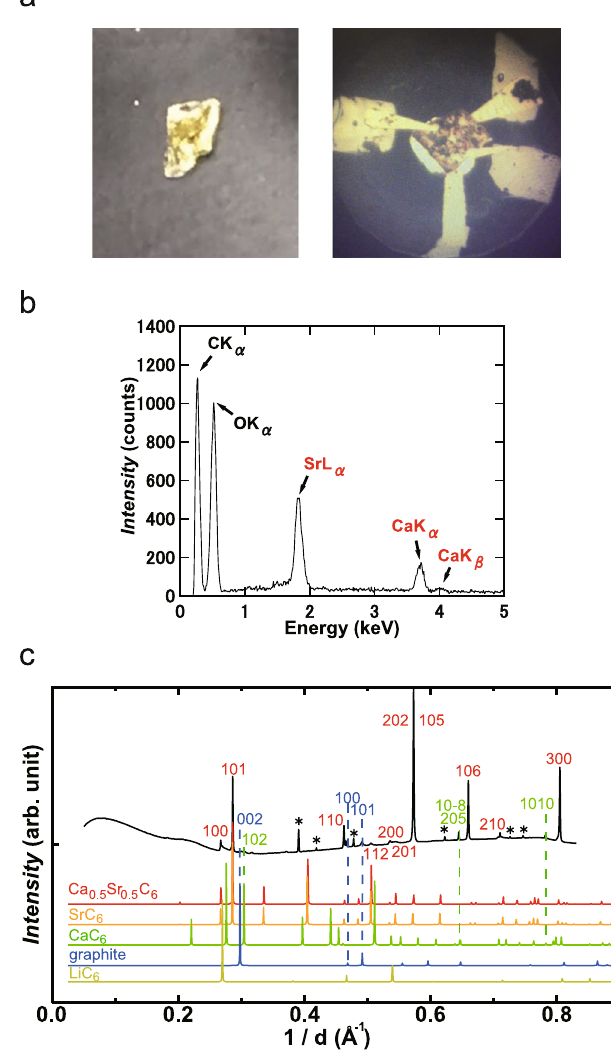
Figure 2. ( a ) Optical image (left) of the Ca 0.8 Sr 0.2 C y sample and microscope image (right) of the sample set in the DAC. ( b ) EDX spectrum of Ca 0.8 Sr 0.2 C y . ( c ) XRD pattern of Ca 0.5(2) Sr 0.5(2) C y . The XRD pattern was measured with synchrotron radiation of λ = 0.68841 Å at room temperature. Patterns shown in ( c ) for Ca 0.5 Sr 0.5 C 6 , SrC 6 , CaC 6 , graphite and LiC 6 were simulated using the VESTA program, using structural data from refs 2, 24, 25 and 26,